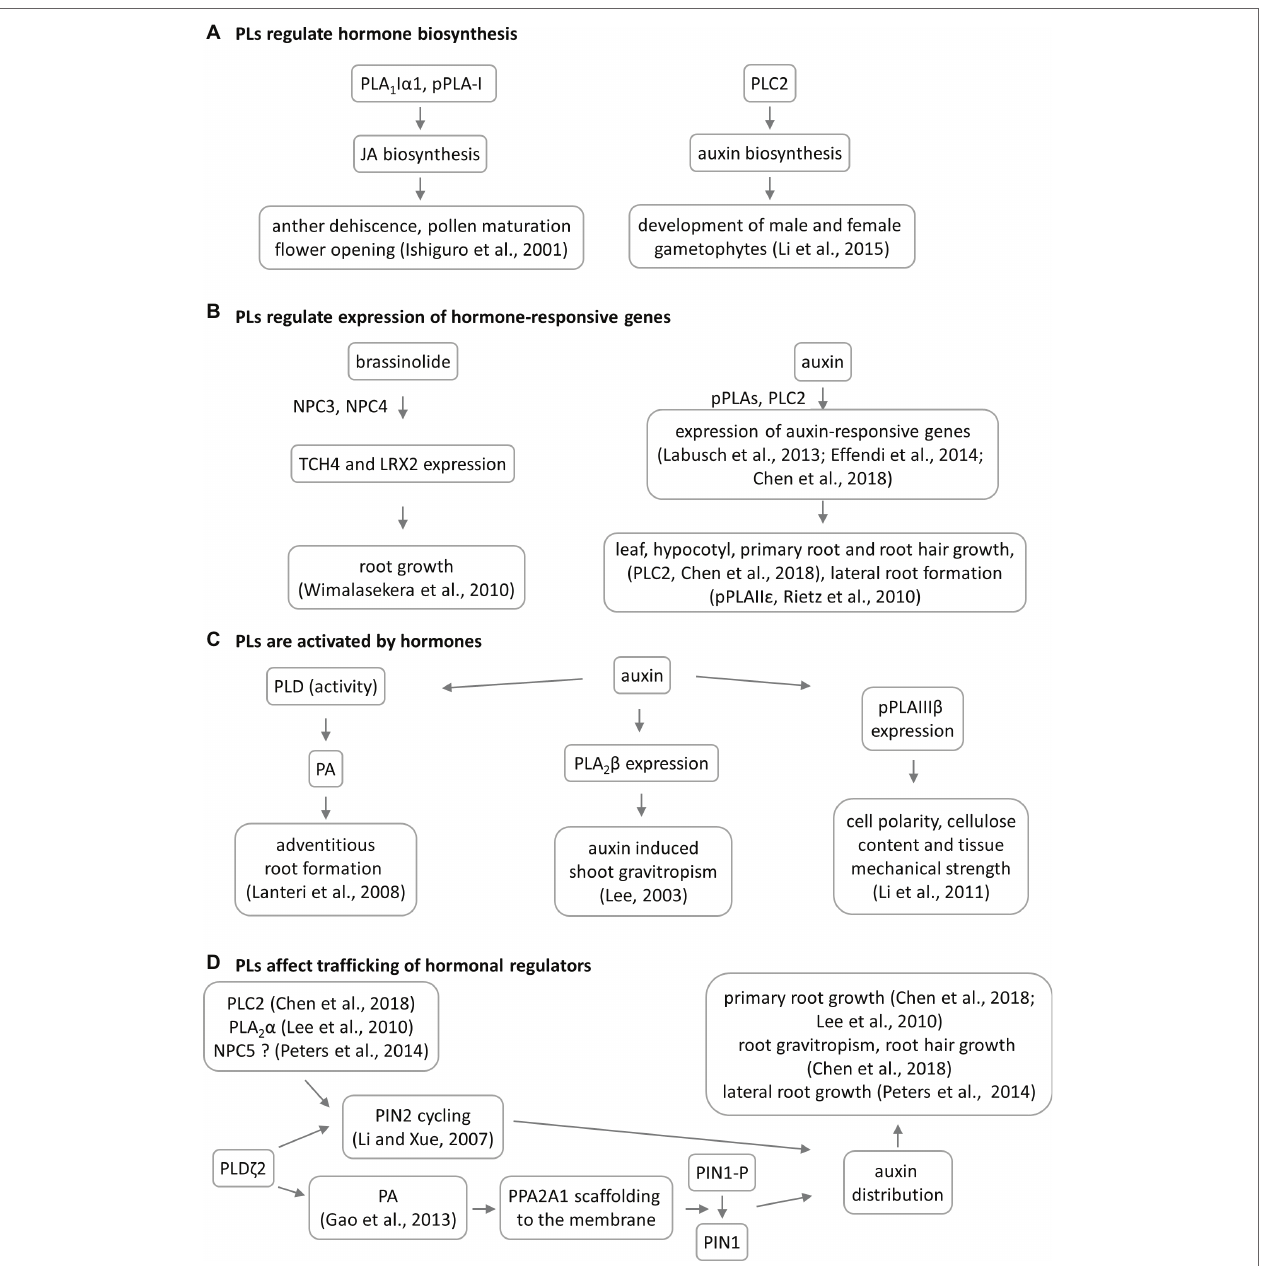
FIGURE 3 | Overview of crosstalk between phospholipases (PLs) and hormones during plant development. Four models of PL–hormone interaction are proposed. (A) PLs are involved in jasmonic acid and auxin biosynthesis. This has consequences in reproductive organ development. (B) PLs are regulating the hormone- induced gene expression having impact on root and shoot development, TCH4 = xyloglucan endotransglycosylase 4, LRX2 = leucine-rich extensin 1. (C) PLs are activated by hormones leading to developmental phenotypes. In some cases, the PL mutation does not lead to phenotypic manifestation. (D) Particular PLs have impact on the auxin distribution through 2 different mechanisms. NPC5 promotes lateral root formation likely through regulating auxin transport and distribution (Peters et al., 2014), which occurs via PIN2